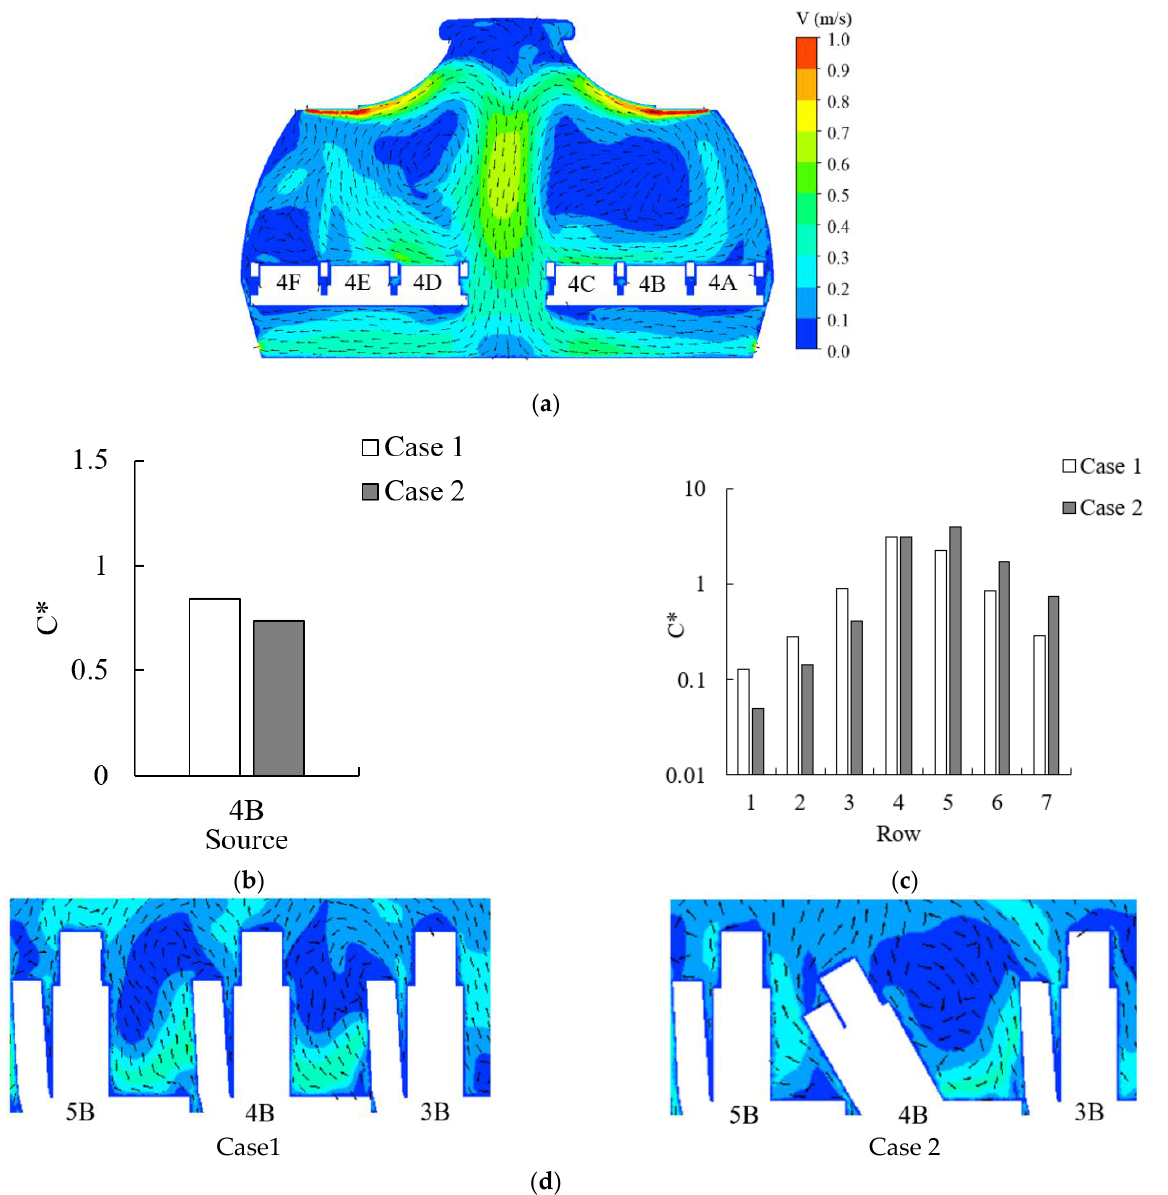
Figure 8. Airflow and normalized pollutant concentrations with seats 4A to 4C inclined in Case 2: ( a ) airflow field in a section across the fourth row, ( b ) average pollutant concentration in respiratory zone of the 21 passengers seated in D to E for the pollutant released from 4B, ( c ) average pollutant